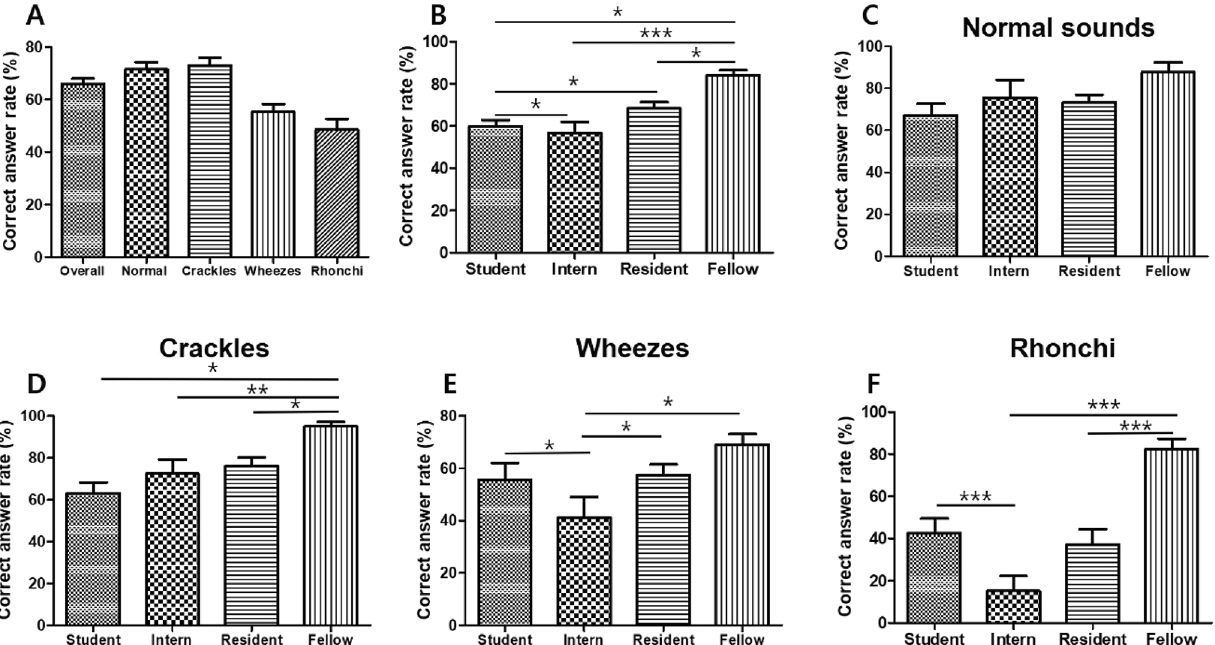
Figure 4. Accuracy of auscultation analysis in real clinical practice. ( A ) Mean correction answer rates for the overall sounds, normal sounds, crackles, wheezes, and rhonchi. ( B ) Mean correction answer rates of students, interns, residents, and fellows for overall sounds. ( C ) Mean correction answer rates of students, interns, residents, and fellows for normal sounds ( D ) Mean correction answer rates of students, interns, residents, and fellows for crackles ( E ) Mean correction answer rates of students, interns, residents, and fellows for wheezes. ( F ) Mean correction answer rates of students, interns, residents, and fellows for rhonchi. * p < 0.05, ** p < 0.05 *** p < 0.001 (Student’s